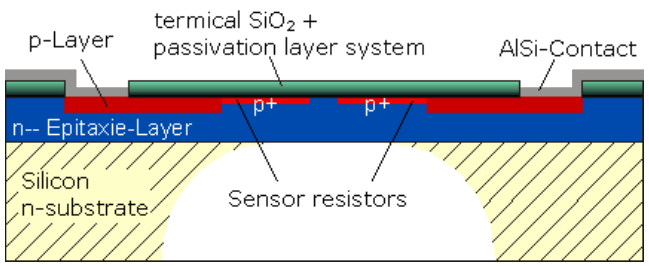
Figure 13. Piezoresistive pressure sensor construction